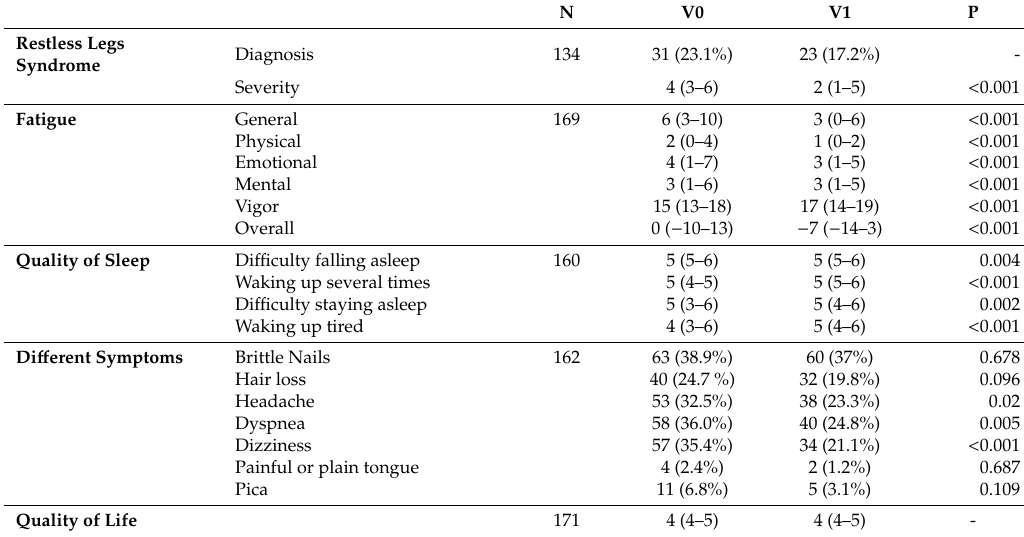
Table 2. Clinical outcome data at V0 and V1. Nominal data are presented as N (%), ordinal data as Median (IQR).